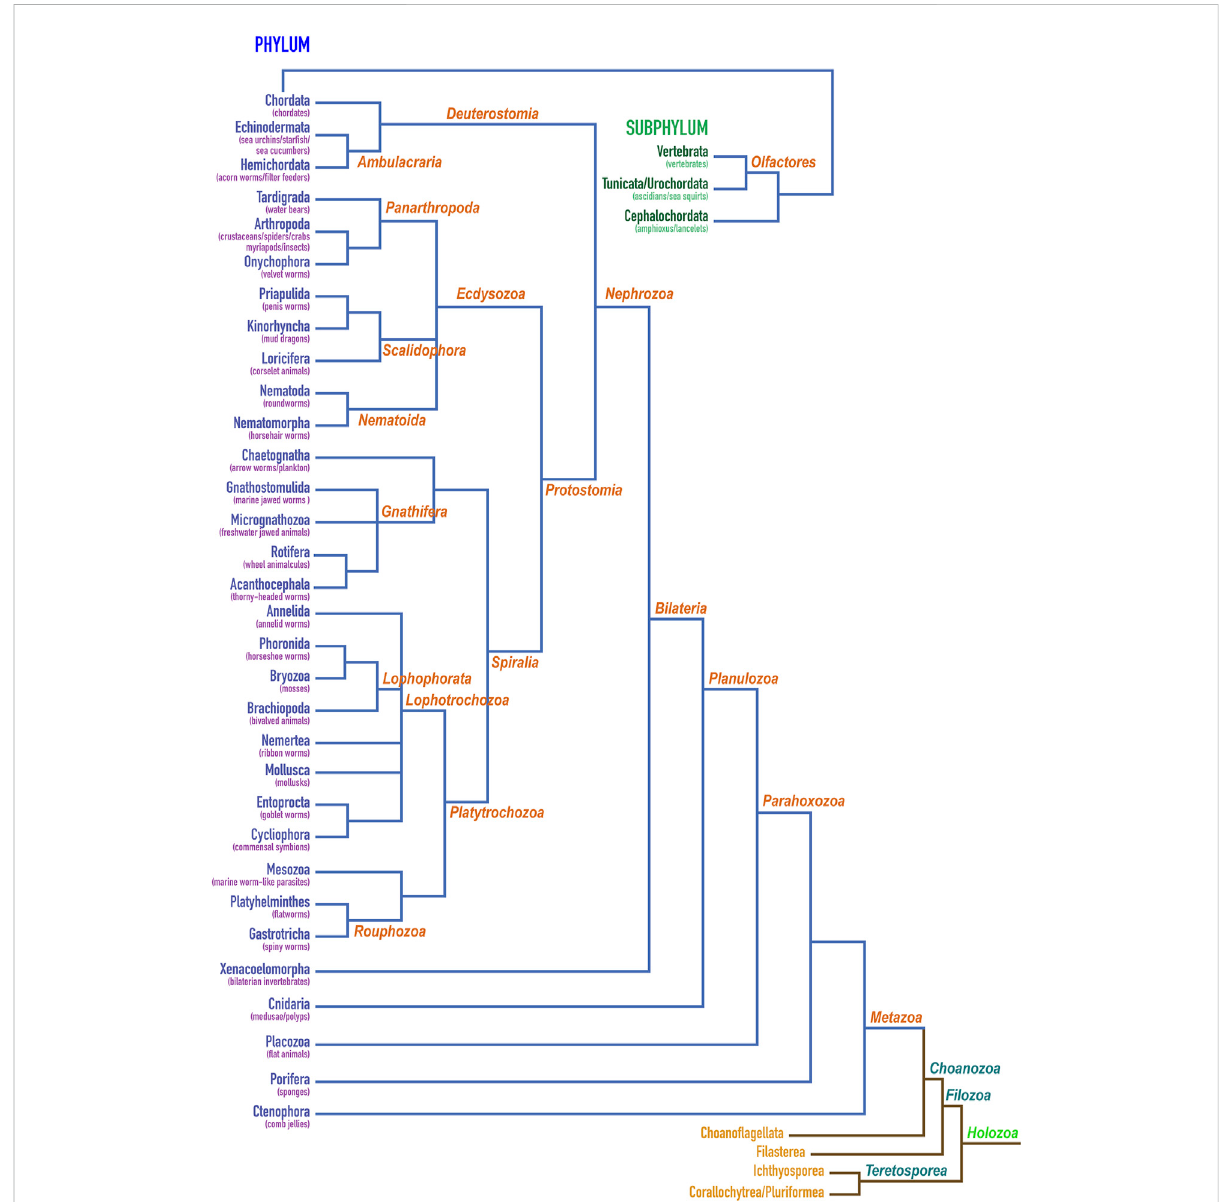
FIGURE 3 Classi fi cation of holozoans. Dendrogram depicting the herein proposed hierarchical clustering of phyla within holozoans assembled based on current literature (Ryan et al., 2010; Ruggiero et al., 2015; Torruella et al., 2015; Cannon et al., 2016; Lu et al., 2017; Sebé-Pedrós et al., 2017; Whelan etal.,2017;Adletal.,2019;Giribetetal.,2019;Laumeretal.,2019;Marlétazetal.,2019;Sogabeetal.,2019;Hickmanetal.,2020;Schochetal.,2020; Schulze and Kawauchi, 2021). Phylum Chordata is further shown for its constituting subphyla Vertebrata, Tunicata/Urochordata and Cephalochordata. The fi rst two give rise to